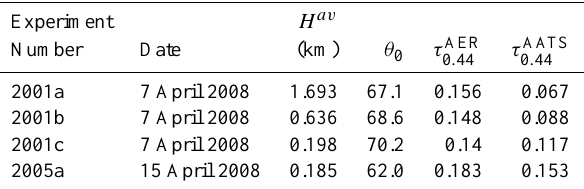
Table 2. Summary of CAR P-3B snow BRF experiments over Bar- row. The last four columns give the average flight altitude, solar zenith angle and aerosol optical thickness of atmospheric column (AERONET) and of the layer above airplane (AATS) in the blue